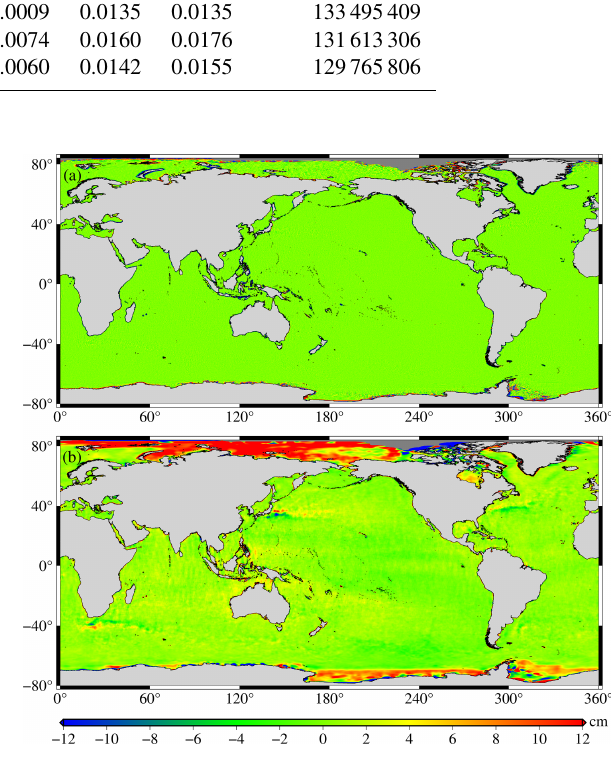
Figure 8. Differences between CLS15 and DTU18: (a) wavelength less than 150km and (b) wavelength greater than 150km.